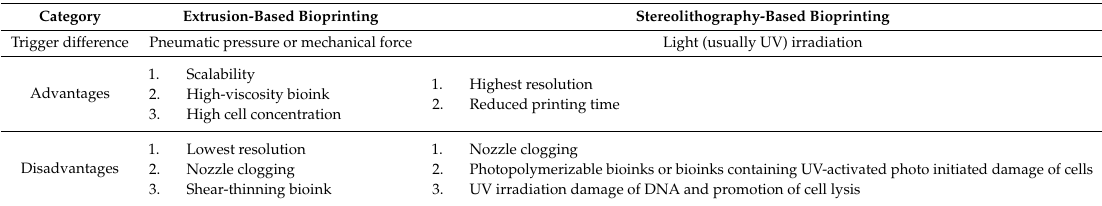
Table 3. The advantages and disadvantages of extrusion-based bioprinting and